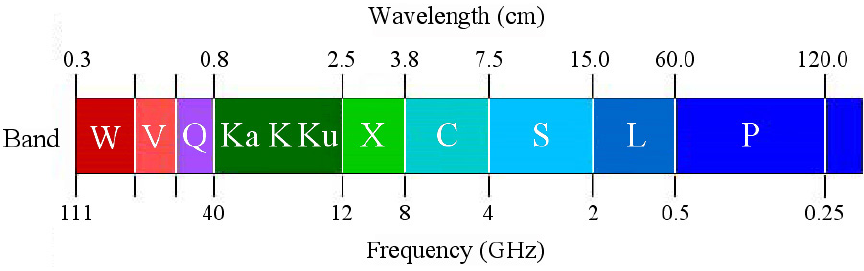
Figure 2. One-way transmission rate (%) of microwave through vapor clouds, ice